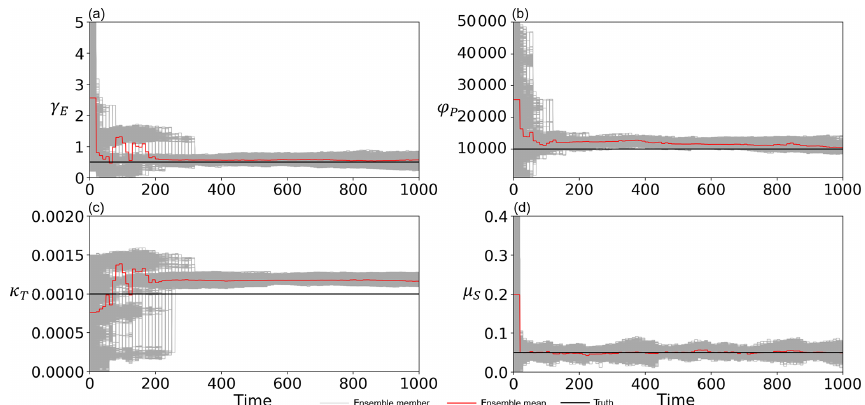
Figure 7. Time series of (a) the cost of levee raising γ E , (b) the rate at which new properties can be built ϕ P , (c) the rate of decay of levees κ T , and (d) the memory loss rate µ S estimated by the data assimilation of all observations ( F , G , D , H , and M ), with 5000 ensembles every 10 years, in experiment 2 (see Sect. 3.1.2). The time step is annual. Gray, red, and black lines are the ensemble members, their mean, and the synthetic truth, respectively.